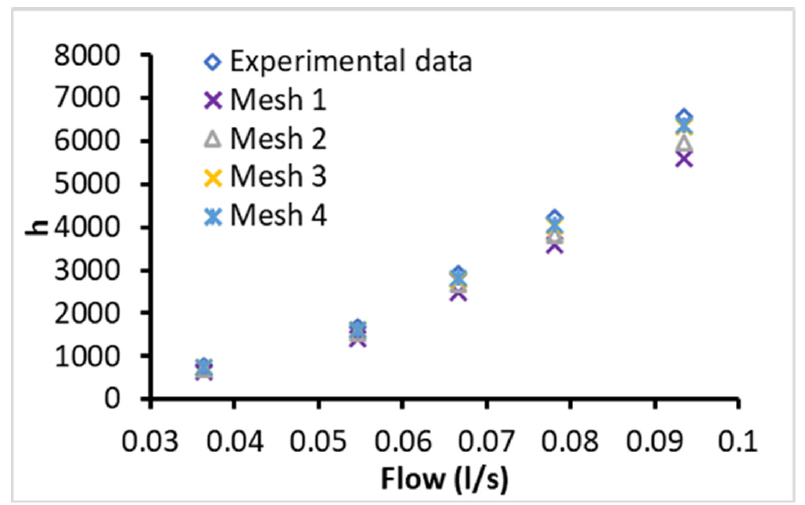
Figure 5. Mesh independency and validation for CHTC ( h ) of BF as a function of flow rate.